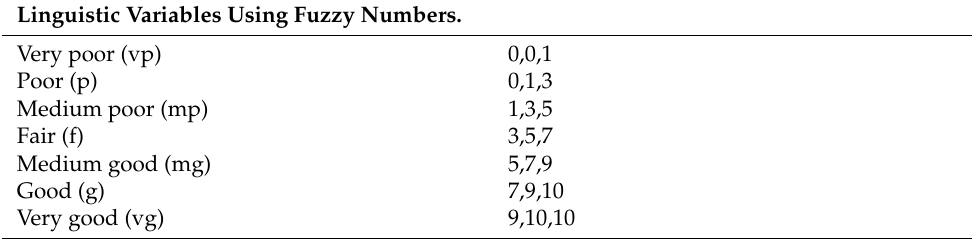
Table 6. Linguistic variables using fuzzy